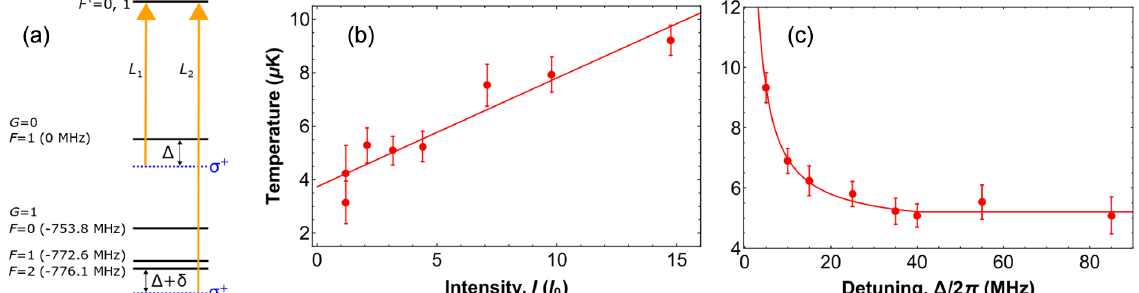
FIG. 2. Characterization of GMC. (a) Configuration of laser detunings. (b) Temperature versus intensity I with single-photon detuning Δ ¼ 8 . 3 Γ and Raman detuning δ ¼ 0 between the G ¼ 0 , F ¼ 1 and the G ¼ 1 , F ¼ 2 manifolds. The solid line is a linear fit. (c) Temperature versus Δ with I ¼ 3 . 2 I 0 and δ ¼ 0 . The solid line is a fit to the function T background temperature. The error bars in the plots correspond to 1 σ statistical uncertainty, and the fittings are consistent with the theoretical predictions in Ref.